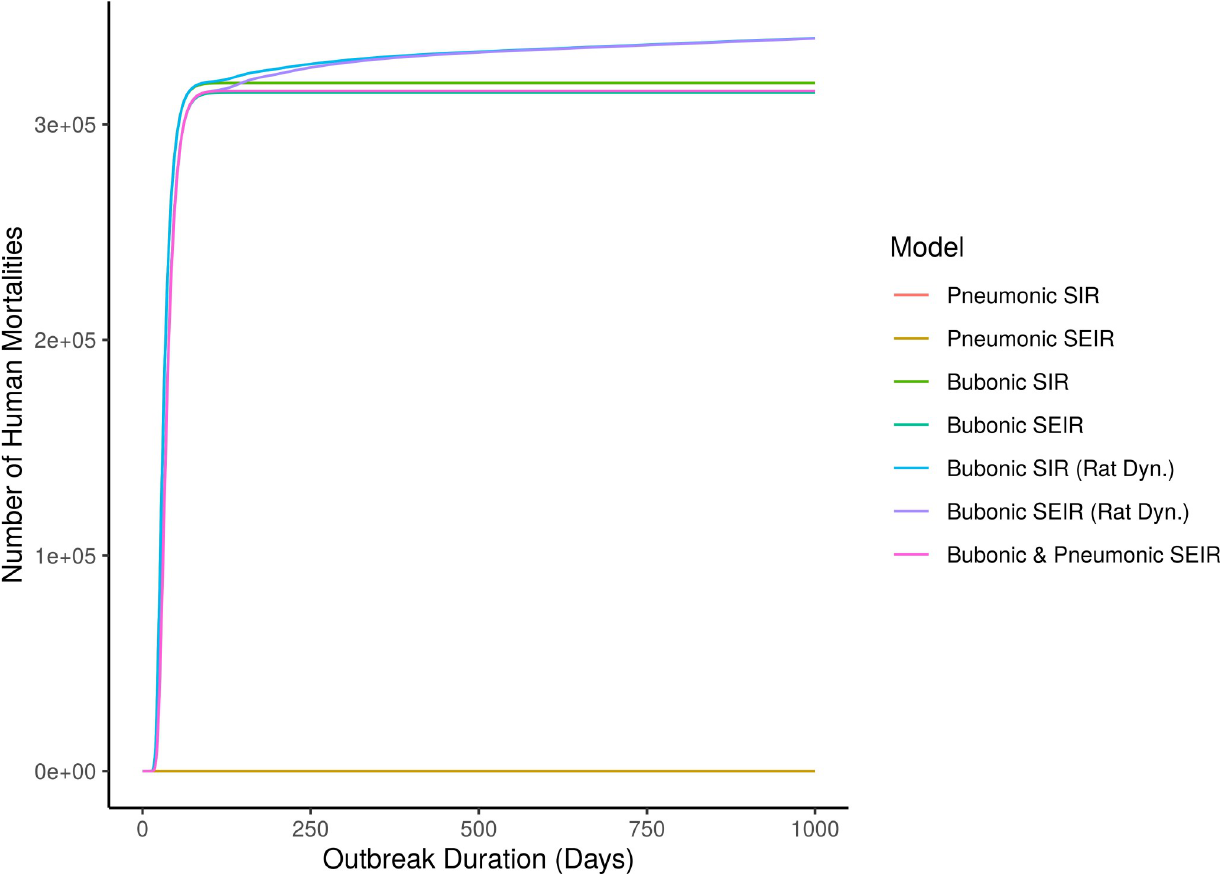
Fig 1. Time course results of different transmission mode models with rat to human ratio of 1:1. Produced using expected transmission values from Table 1. Initial conditions: number of susceptible humans, S h ( t = 0) = 500,000, number of susceptible rats, S r ( t = 0) = 499,999, and number of infected rats, I r ( t = 0) =